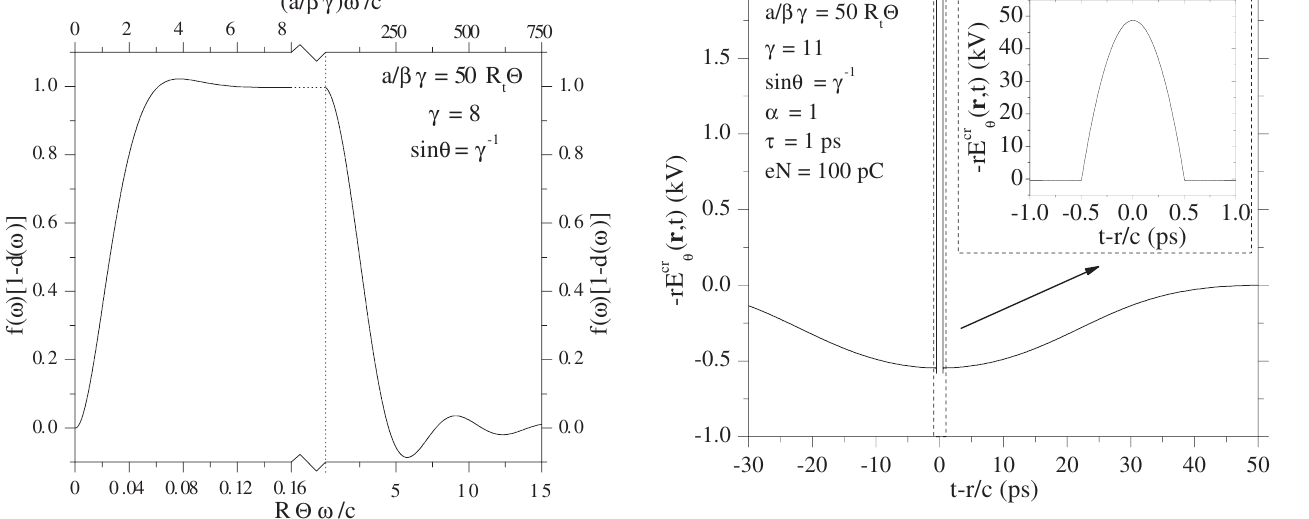
FIG. 3. Frequency dependence of the electric field spectrum of the total coherent radiation pulse due to a hard-edged ellipsoidal electron bunch, including both CTR and CDR. The parameters used to make the plot are listed in the upper right